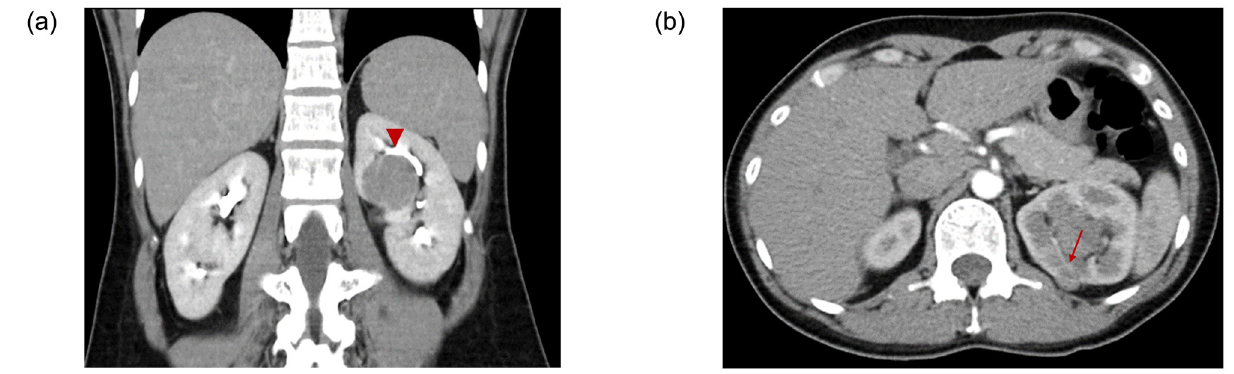
Figure 1: Abdominal CT revealed ( a ) the main endophytic tumor ( arrow head ) in the dorsal interpolar region of left kidney and ( b ) another exophytic tumor ( arrow ) .